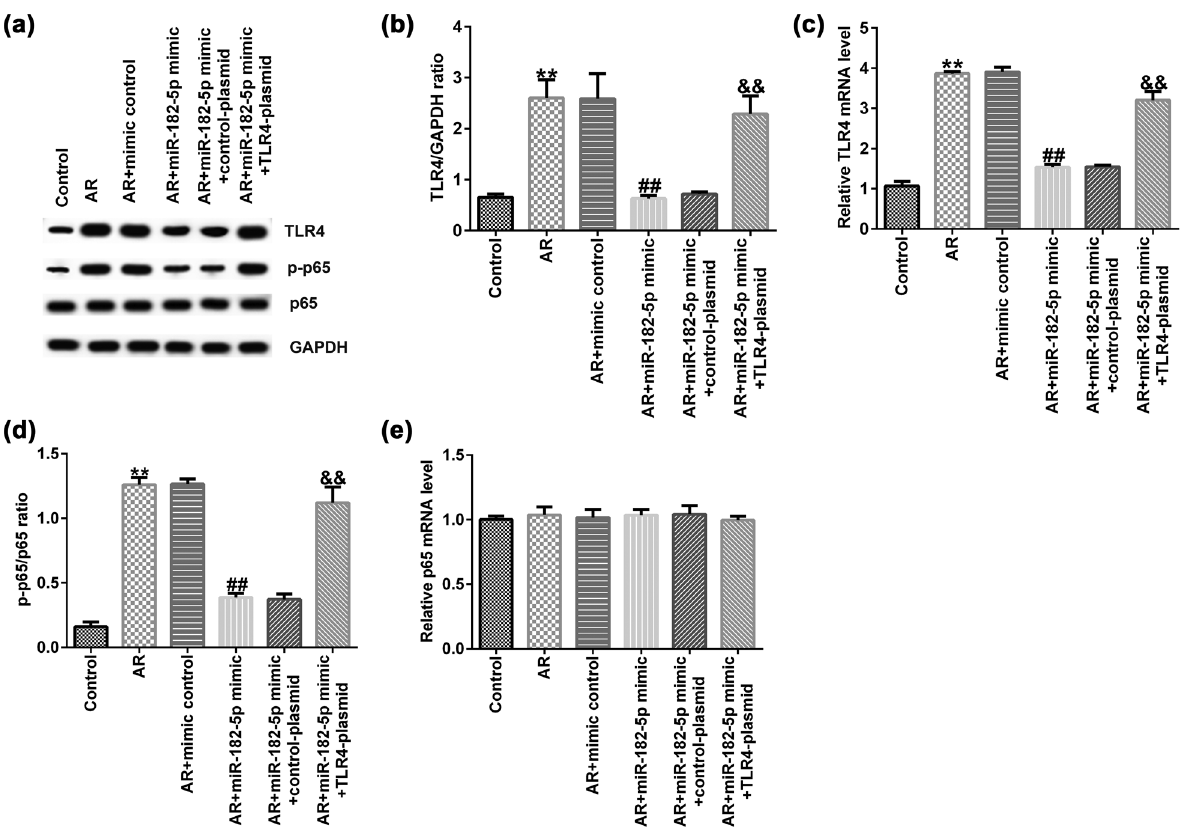
Figure 7: TLR4 reversed the inhibitory e ff ect of miR - 182 - 5p on the NF - κ B signaling pathway. ( a ) Western blot analysis was used to determine TLR4, p65 and p - p65 protein expression. ( b ) TLR4/GAPDH ratio was calculated and presented ( n = 3 ) . ( c ) RT - qPCR analysis was used to assess TLR4 mRNA expression ( n = 3 ) . ( d ) The ratio of p - p65/p65 was calculated ( n = 3 ) . ( e ) qRT - PCR analysis was used to detect p65 mRNA levels ( n = 3 ) . TLR4, toll - like receptor 4; qRT - PCR, quantitative reverse transcription -